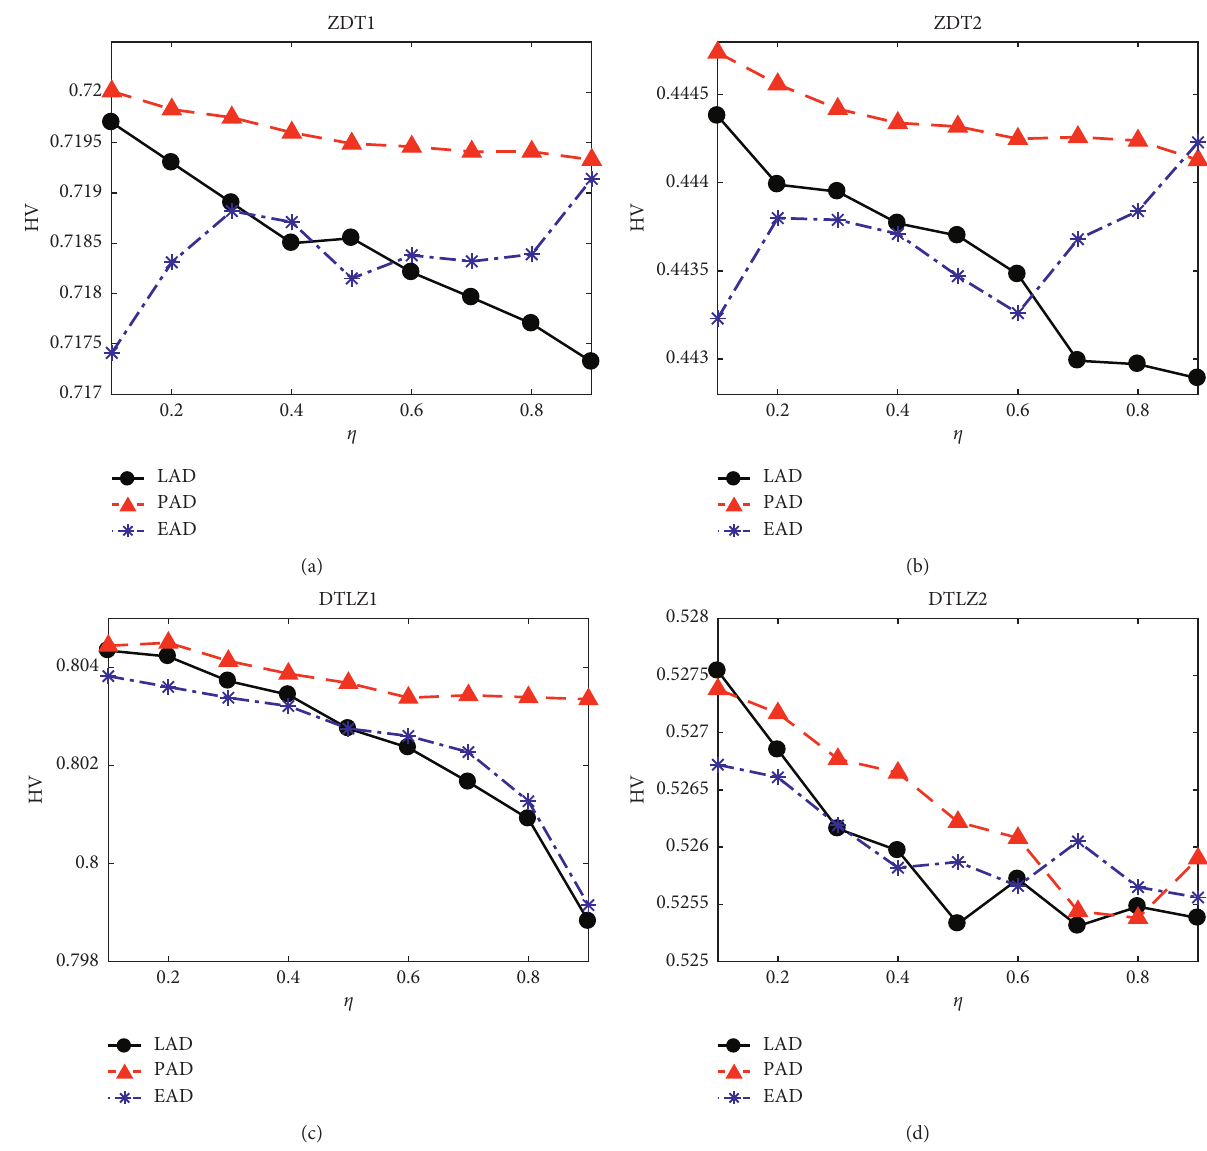
Figure 3: The values of HV changed by η